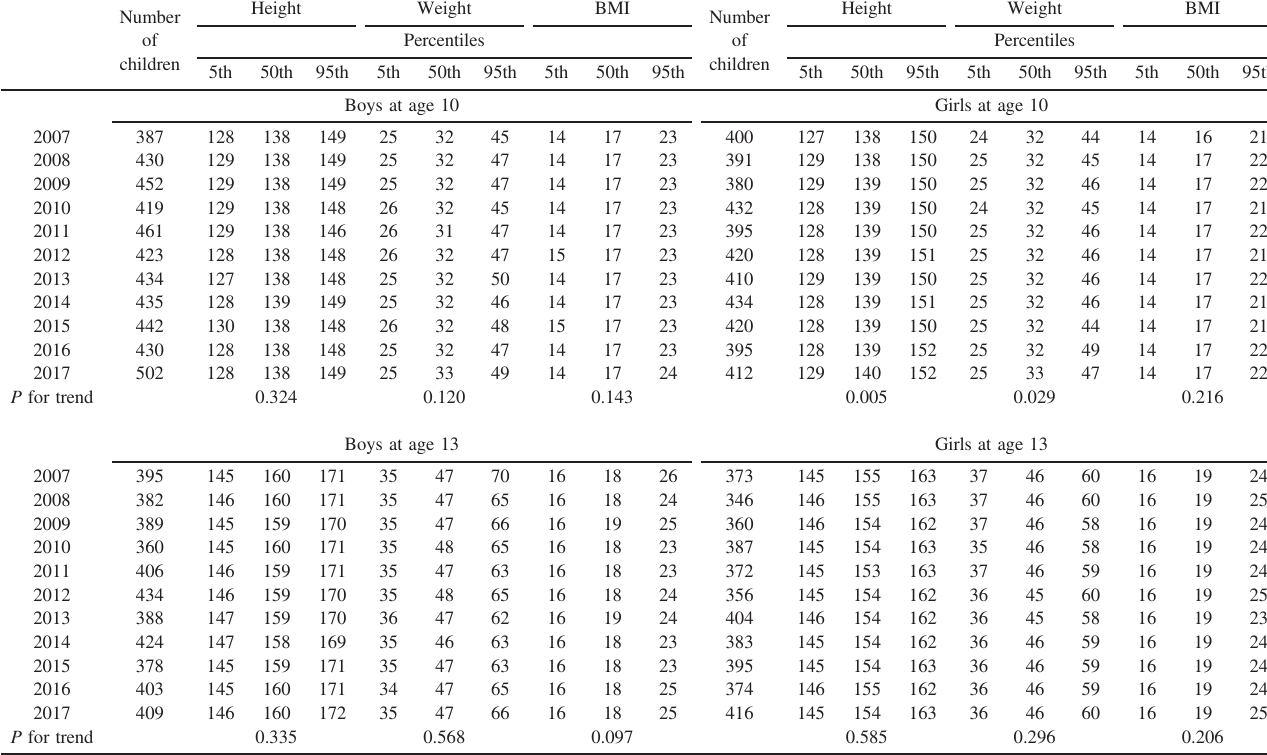
Table 1. Secular trends in anthropometric measurements Number of